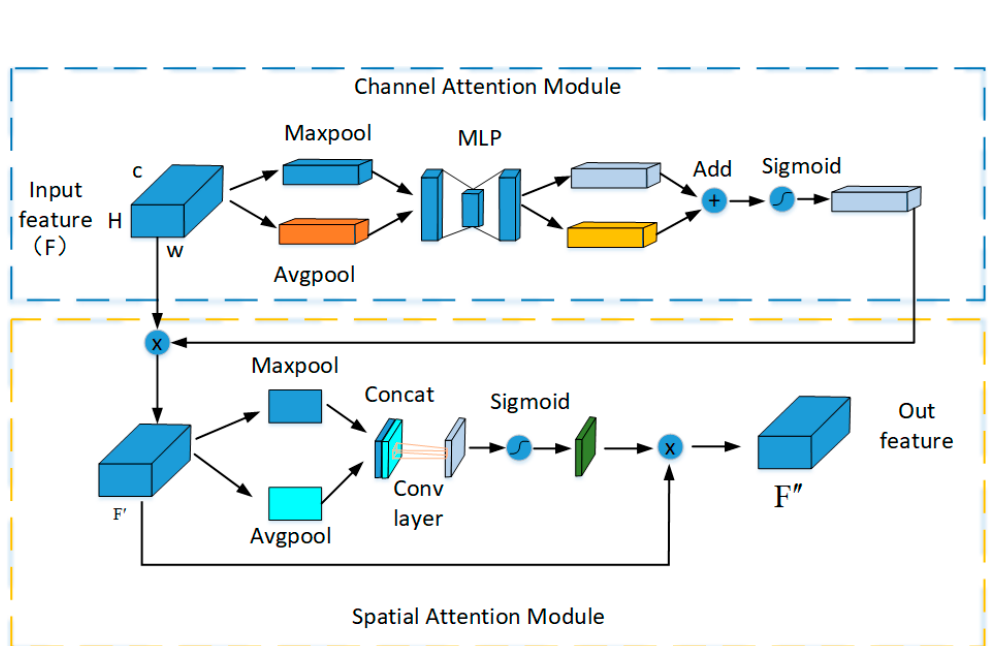
Figure 5. CBAM attention